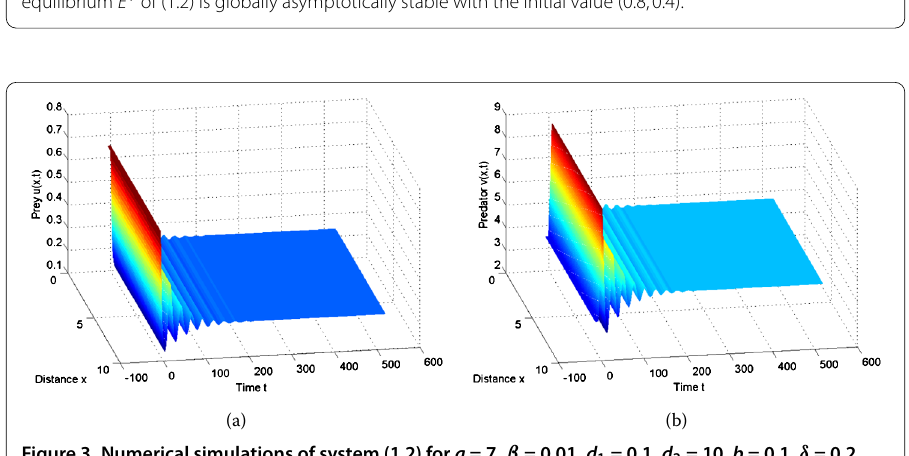
Figure 3 Numerical simulations of system (1.2) for a = 7, β = 0.01, d 1 = 0.1, d 2 = 10, b = 0.1, δ = 0.2. The positive equilibrium E ∗ is locally asymptotically stable with the initial value (0.65,3.5).